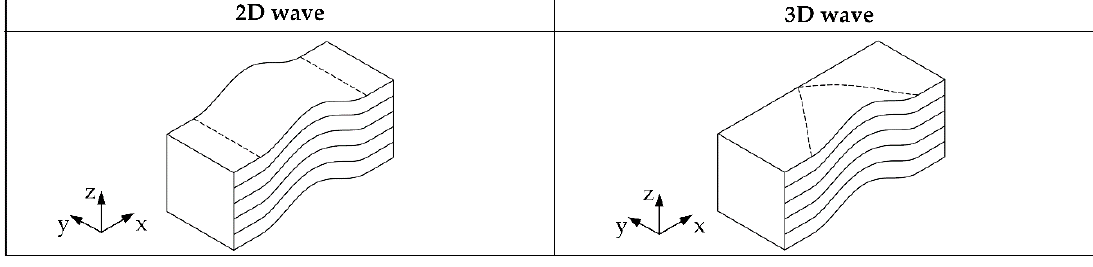
Figure 32. 2D vs. 3D waves.